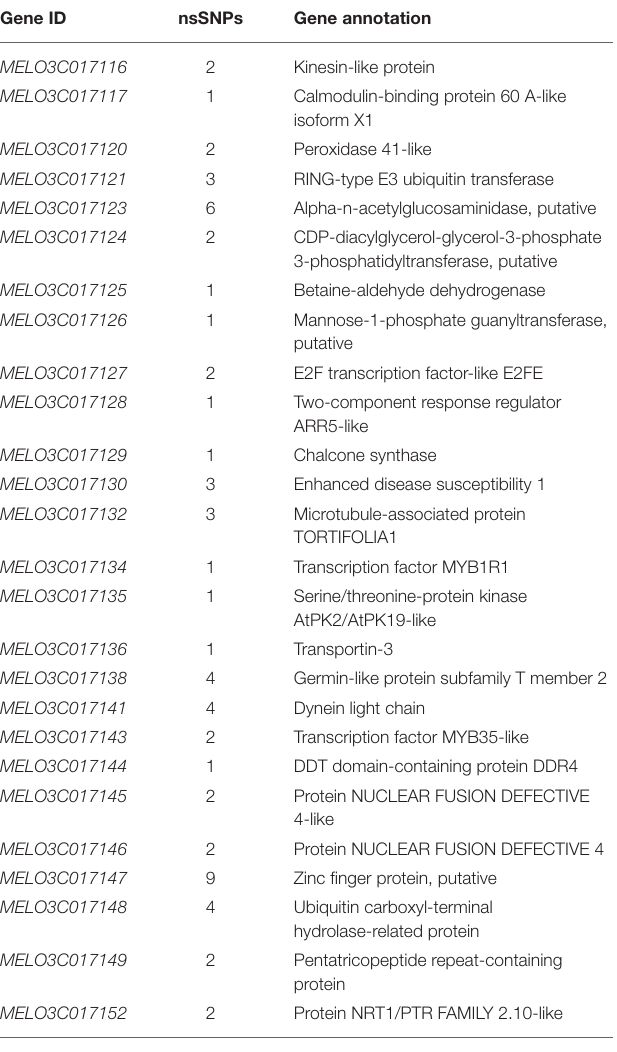
TABLE 5 | Predicted 26 genes with non-synonymous single-nucleotide polymorphisms (SNPs) between markers S2M3 and S2B1-2.